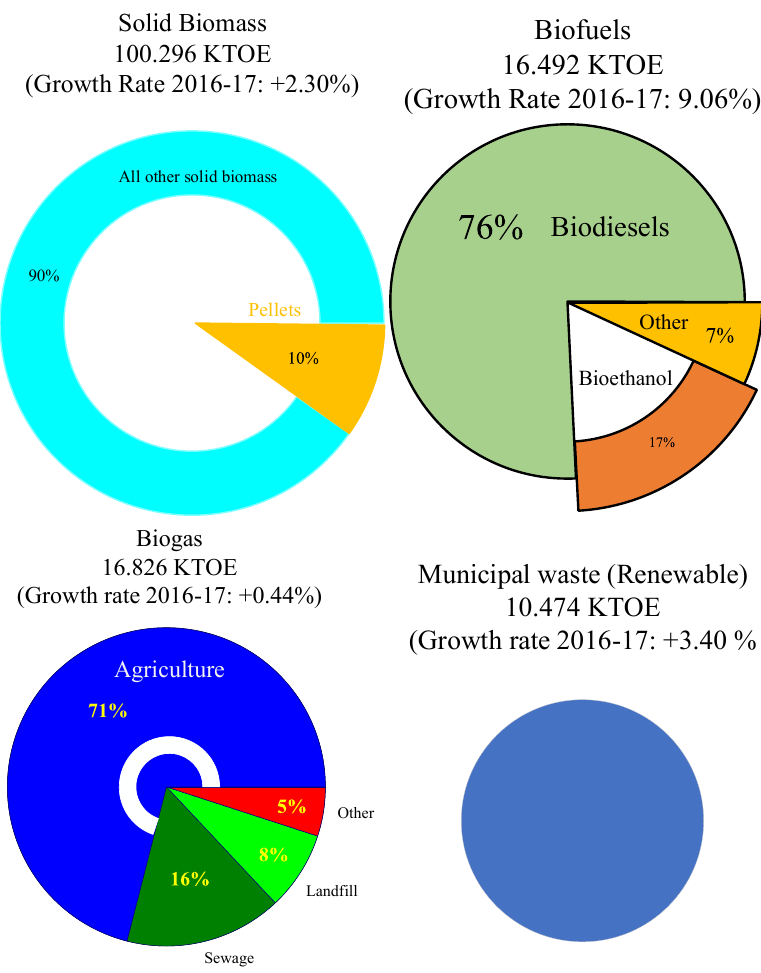
Figure 2. Biomass consumption categorized by type, use, and source in the case of EU-28 in 2017 (total: 144.088 KTOE (million tonnes of oil equivalent)).